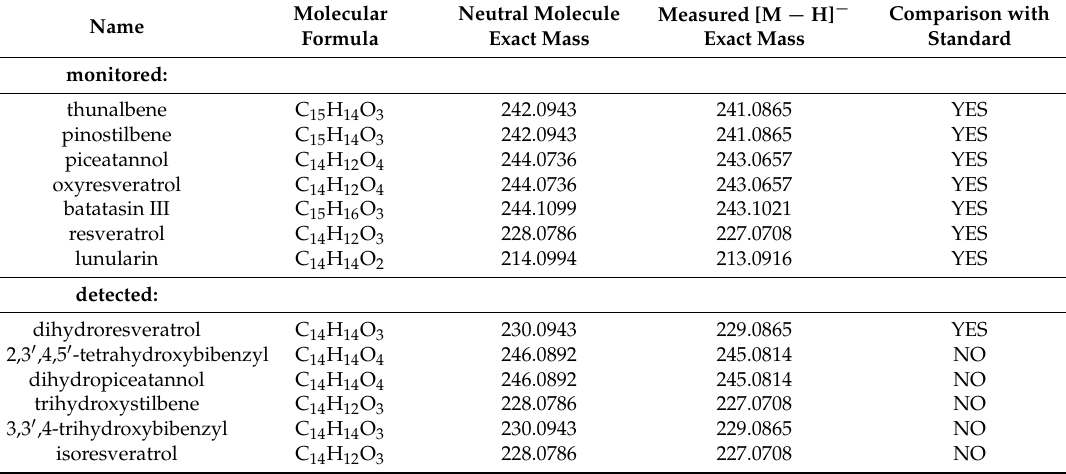
Table A1. List of the stilbenoids monitored and detected in the samples by